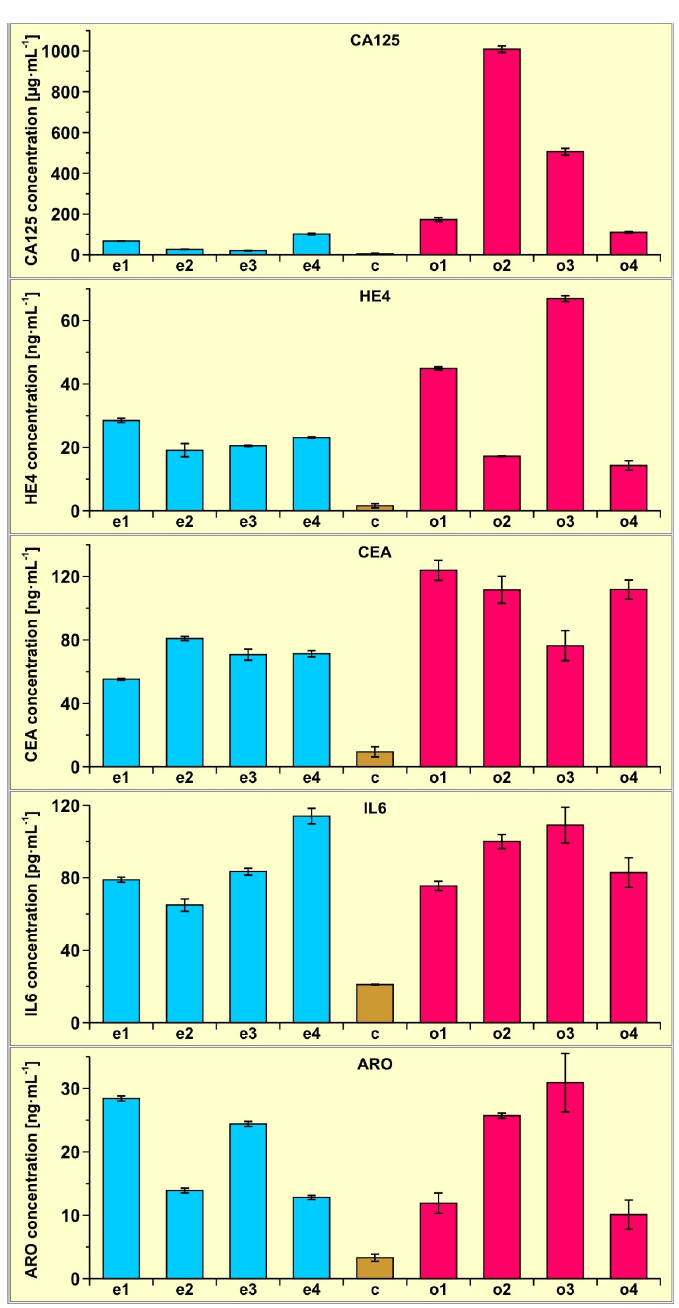
Figure 3. Results of CA125, HE4, CEA, Il-6 and aromatase determination in the plasma of four pa-